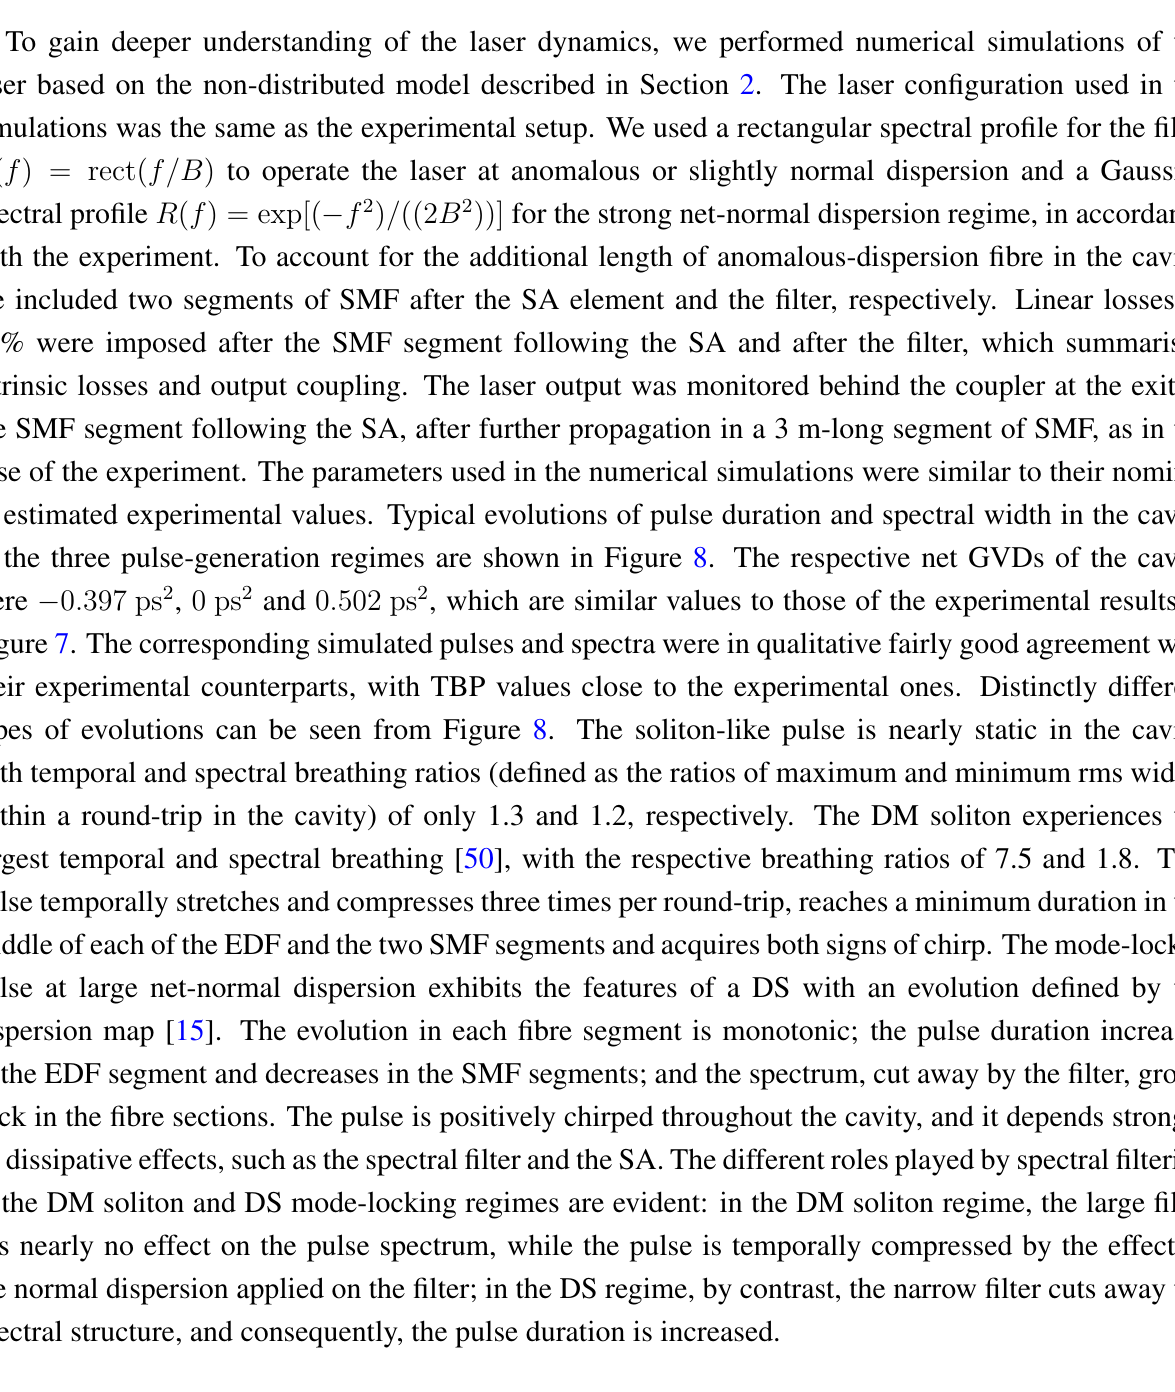
Figure 7. The corresponding simulated pulses and spectra were in qualitative fairly good agreement with their experimental counterparts, with TBP values close to the experimental ones. Distinctly different types of evolutions can be seen from Figure 8. The soliton-like pulse is nearly static in the cavity, with temporal and spectral breathing ratios (defined as the ratios of maximum and minimum rms widths within a round-trip in the cavity) of only 1.3 and 1.2, respectively. The DM soliton experiences the largest temporal and spectral breathing [50], with the respective breathing ratios of 7.5 and 1.8. This pulse temporally stretches and compresses three times per round-trip, reaches a minimum duration in the middle of each of the EDF and the two SMF segments and acquires both signs of chirp. The mode-locked pulse at large net-normal dispersion exhibits the features of a DS with an evolution defined by the dispersion map [15]. The evolution in each fibre segment is monotonic; the pulse duration increases in the EDF segment and decreases in the SMF segments; and the spectrum, cut away by the filter, grows back in the fibre sections. The pulse is positively chirped throughout the cavity, and it depends strongly on dissipative effects, such as the spectral filter and the SA. The different roles played by spectral filtering in the DM soliton and DS mode-locking regimes are evident: in the DM soliton regime, the large filter has nearly no effect on the pulse spectrum, while the pulse is temporally compressed by the effect of the normal dispersion applied on the filter; in the DS regime, by contrast, the narrow filter cuts away the spectral structure, and consequently, the pulse duration is